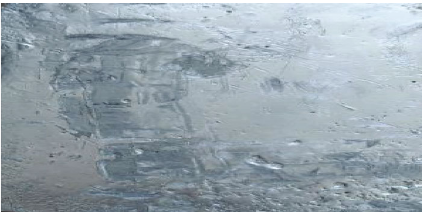
Figure 5: Bottle and recycled PET FTIR spectrum.